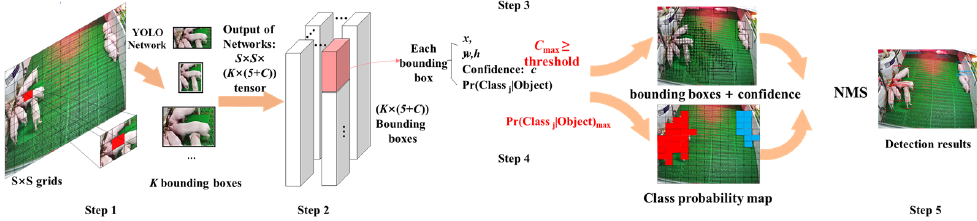
Figure 4. The primary principle of